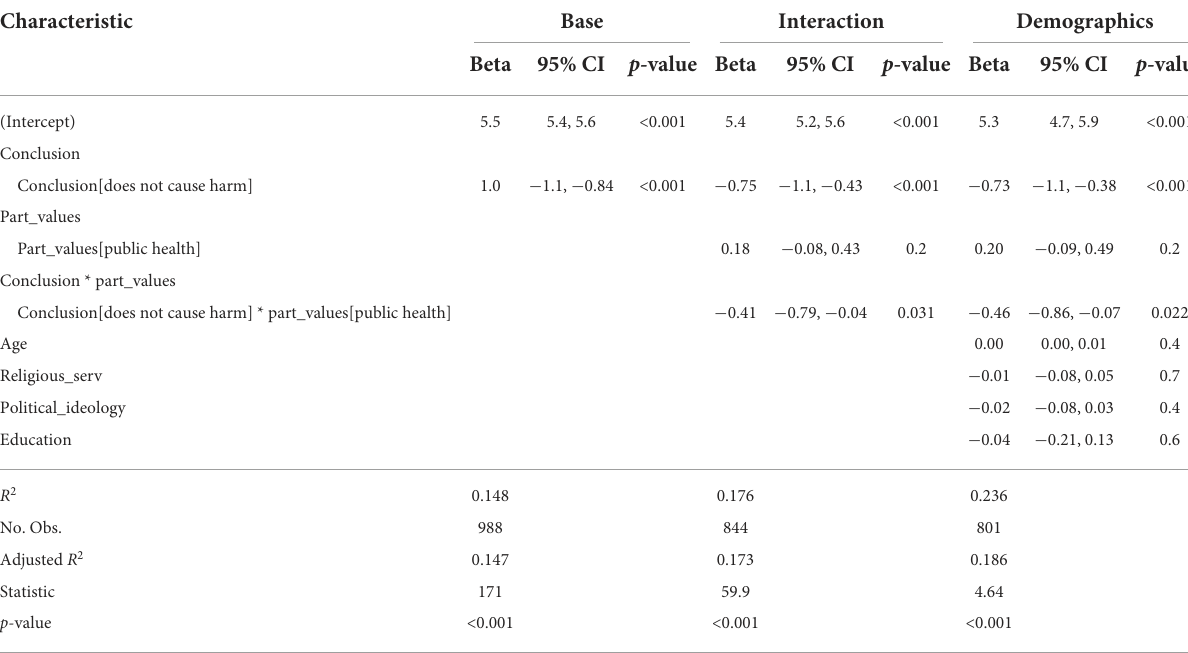
TABLE 4 Regression analysis of H5-consumer, interaction between participant values and consumer risk sensitivity. Characteristic Base Interaction